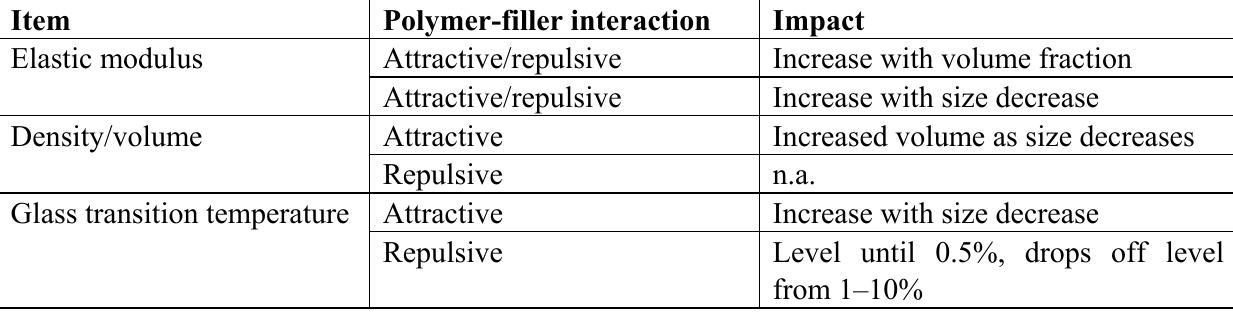
Table 3. Impact of nanoparticles on composite properties with amorphous polymer matrix.